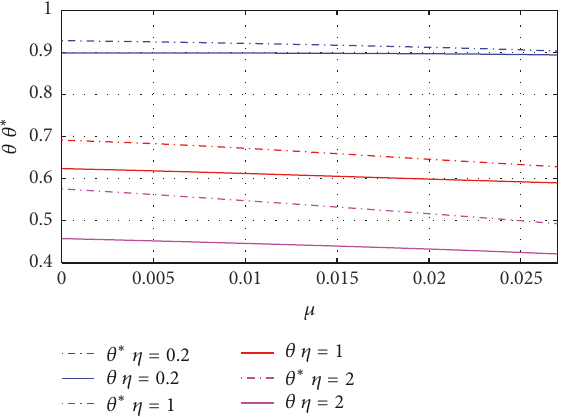
Figure 2: Dependence of 𝜃 ∗ and 𝜃 on 𝜇